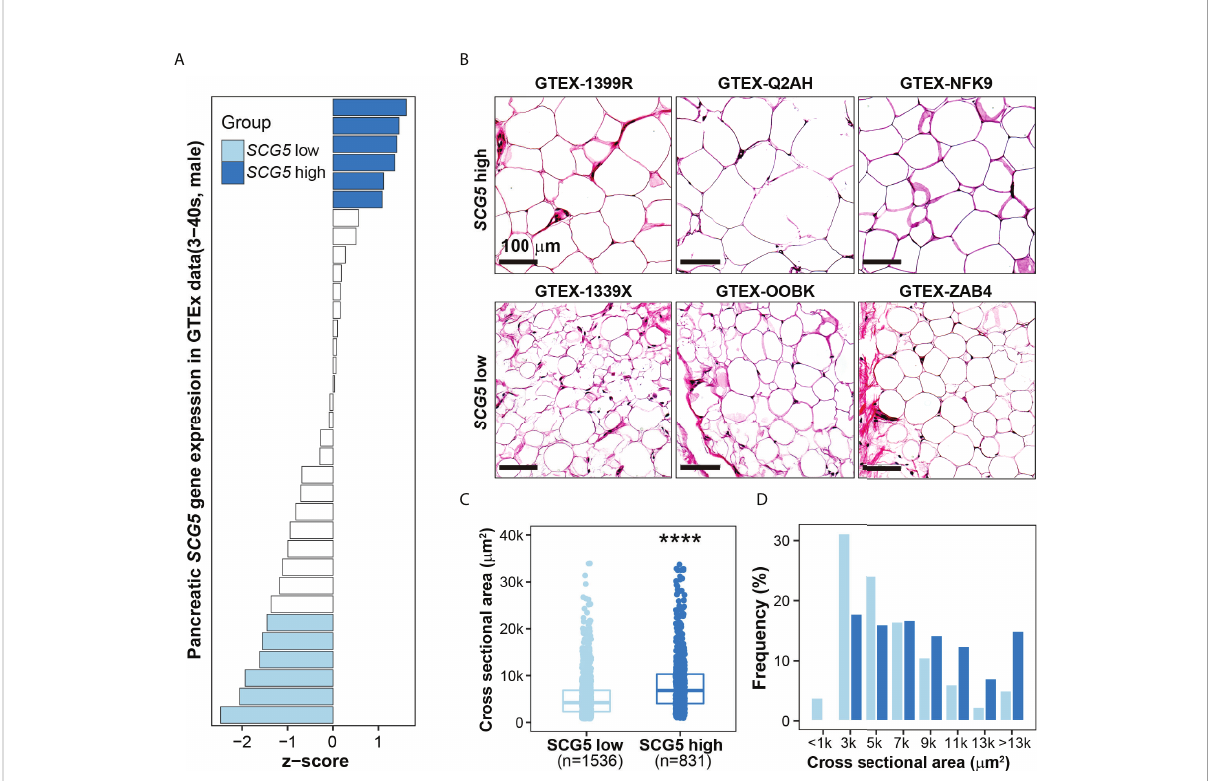
FIGURE 5 SCG5 expression in human pancreatic tissues is positively associated with the size of subcutaneous adipocytes. (A) Bar plot showing pancreatic expression of SCG5 in the human Genotype-Tissue Expression (GTEx) portal. (B) Hematoxylin and eosin-stained images of human subcutaneous adipose tissues from the GTEx portal, (C, D) Plots displaying the (C) size and (D) distribution of the cross-sectional area of adipocytes from H&E-stained histological images. The boxplots (C) present the 25% quartile, the median, and 75% quartile. Student ’ s t - test (C) assessed the statistical signi fi cance. ****p <